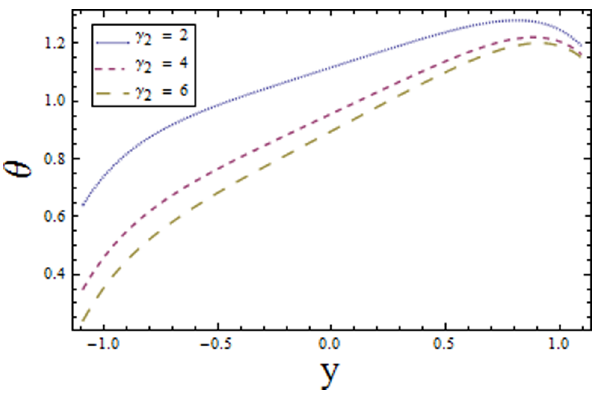
Figure 4. Plot of temperature h for Biot number ª 2 with E ~ 0 : 1 , t ~ 0 : 01 , x ~ 0 : 2 , ª 1 ~ 4 , Br ~ 1 E 1 ~ 0 : 4 ,